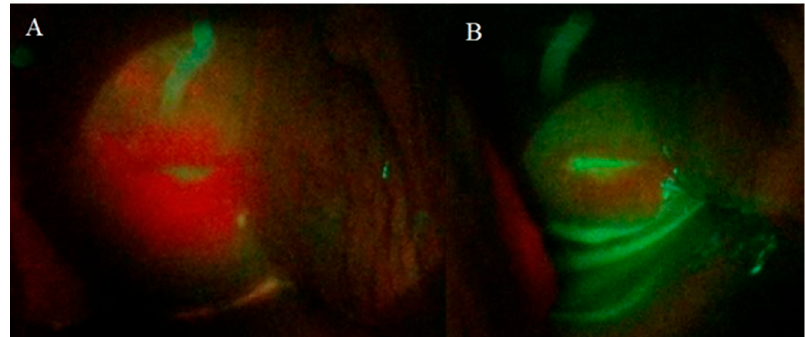
Figure 3. Cervix images of a patient with CIN 1 obtained with CerCa 150 Systems® coupled with Sony Xperia®. Panel A : protoporphyrin IX (PpIX) fluorescence in the cervix and Panel B : cervix fluorescence after PDT (LED 630 nm, 80 mw/cm 2 , with a total dose of 100 J/cm 2 ).